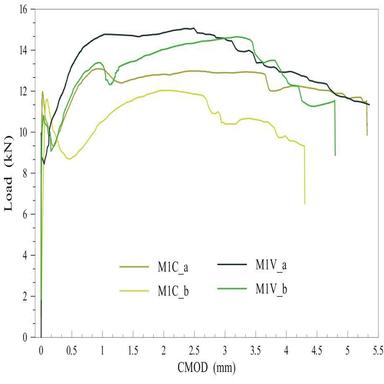
Mortar M1: Load – CMOD curves.